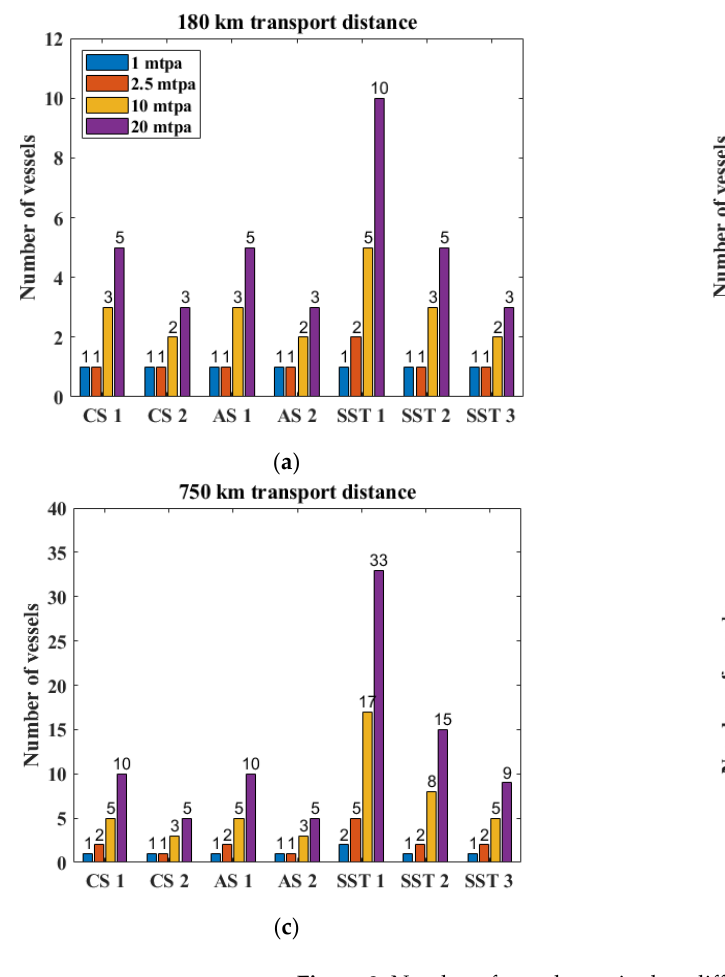
Figure 7. Mean cost per ton of CO 2 results on different source volumes and transport distances: ( a ) 180 km; ( b ) 500 km; ( c ) 750 km; ( d ) 1500 km. OP: Offshore pipeline; CS 1: Crewed ship (Cargo 22,000 m 3 ); CS 2: Crewed ship (Cargo 41,000 m 3 ); AS 1: Autonomous ship (Cargo 22,000 m 3 ); AS 2: Auton- omous ship (Cargo 41,000 m 3 ); SST 1: Subsea shuttle tanker (Cargo 10,569 m 3 ); SST 2: Subsea shuttle